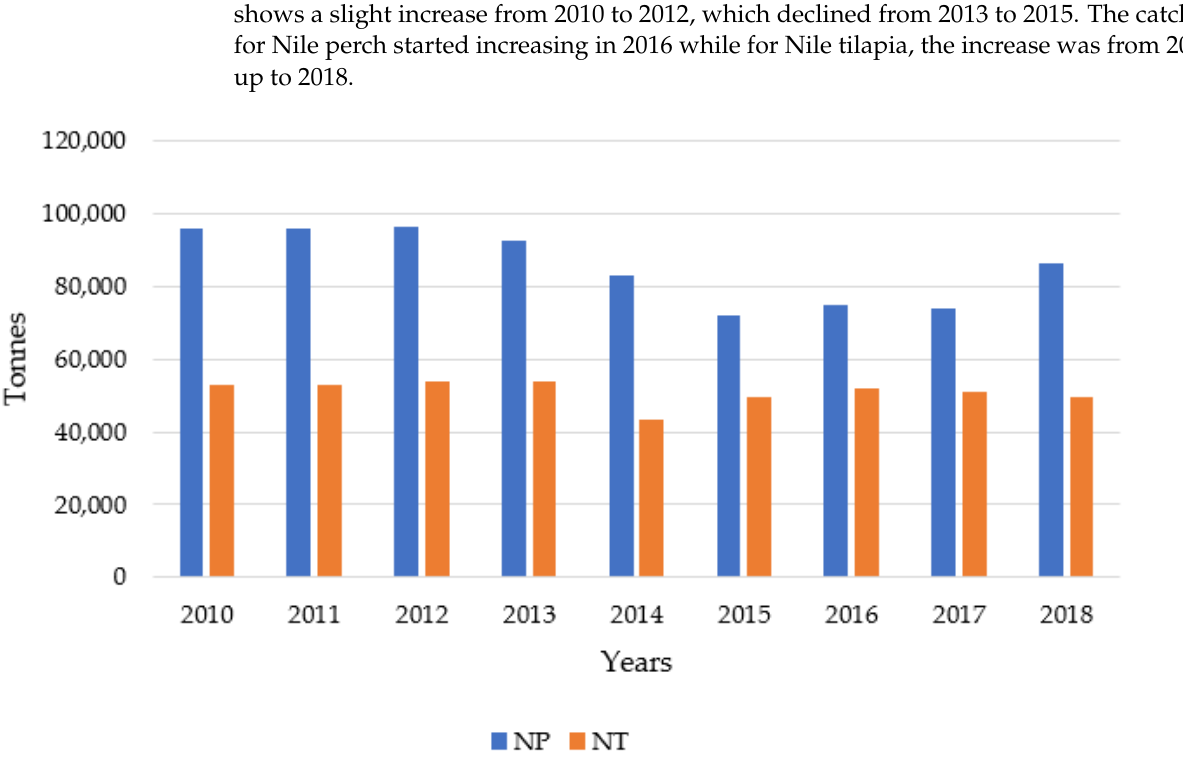
Figure 7. Lake Kyoga Nile perch and Nile tilapia recorded catches in tonnes from 2010 to 2018 (source: NaFIRRI).